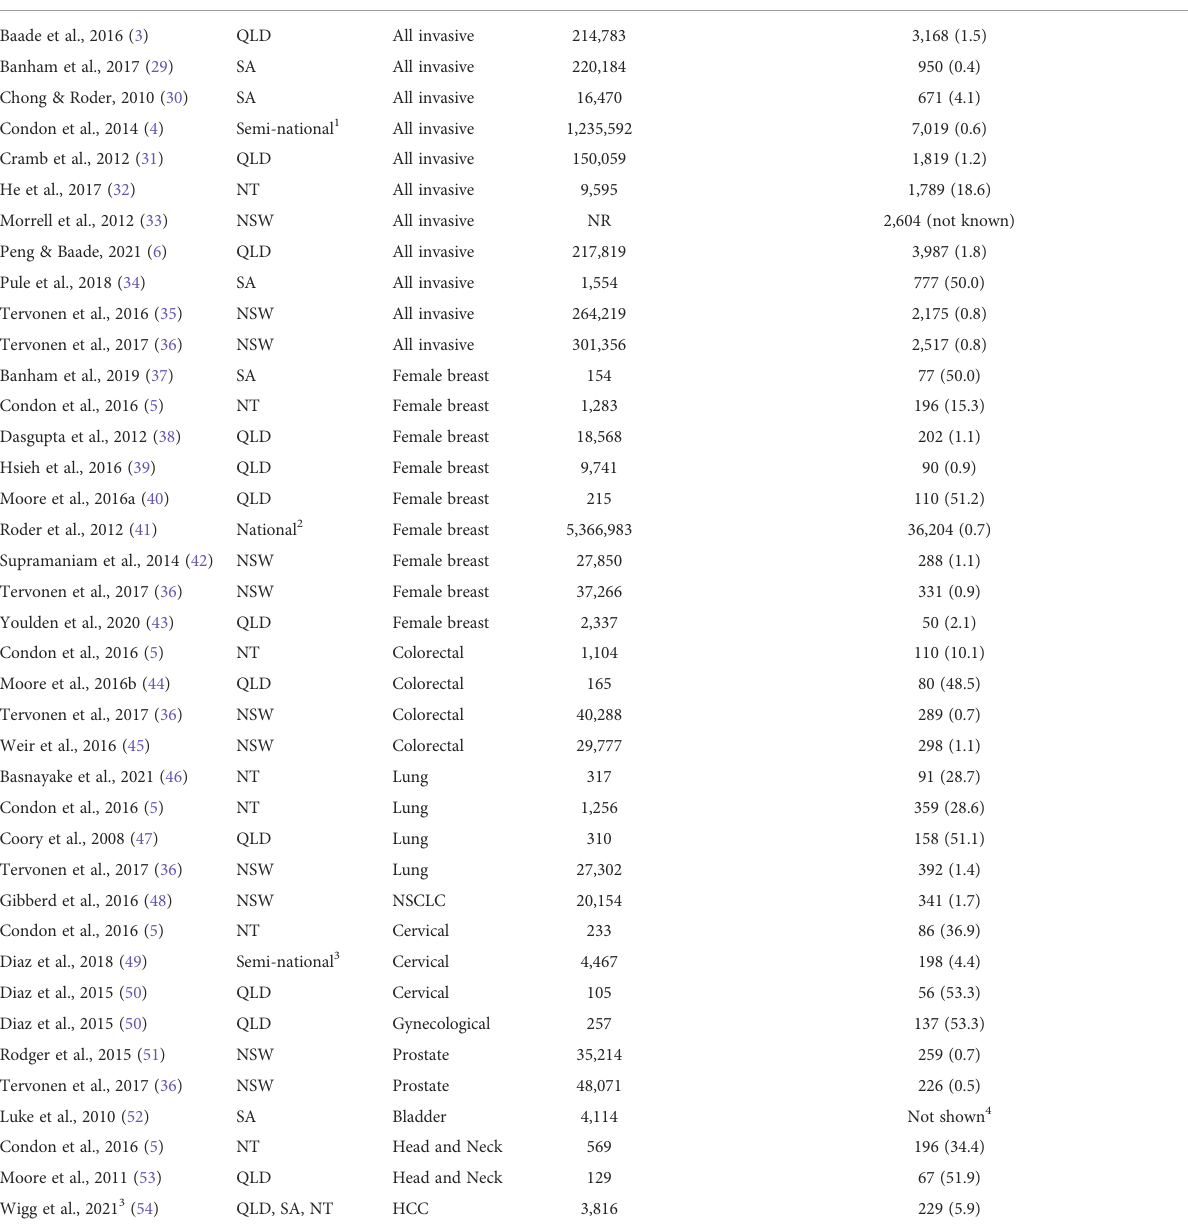
TABLE 1 Key characteristics of included